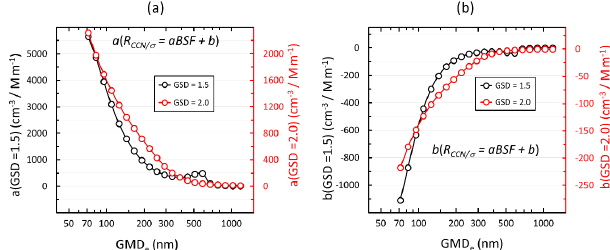
Figure 11. Size distributions of the coefficients of the linear re- gressions of R CCN /σ ( λ = 550nm) vs. backscatter fraction BSF ( λ = 550nm) of narrow and wide size distributions. (a) Slopes of R CCN /σ vs. BSF; (b) offsets of R CCN /σ vs. BSF. R CCN /σ was calculated assuming particles larger than 90nm get activated. The regressions were calculated for five consecutive size distributions. GMD e is the geometric mean of the range of the unimodal size dis- tributions used for the